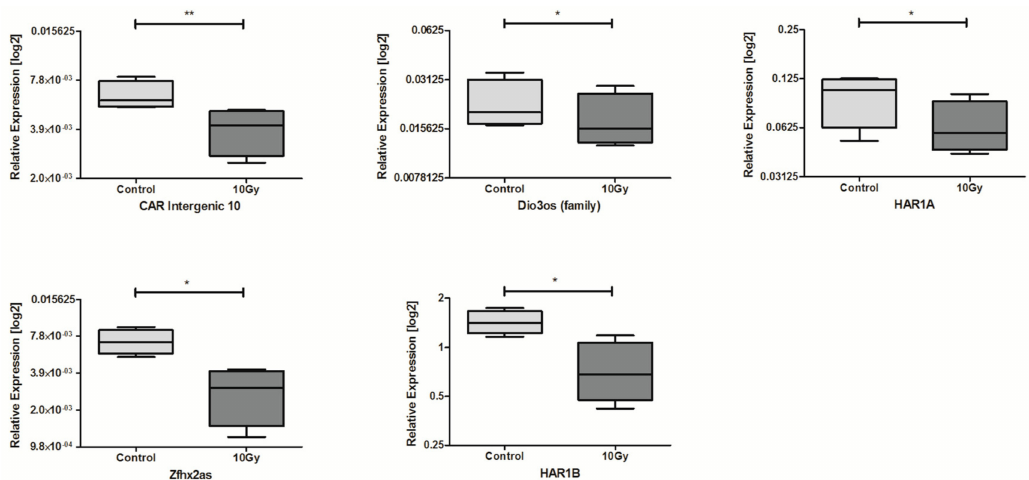
Figure 3. Differences in lncRNAs expression: CAR Intergenic 10, Dio3os (family), HAR1A, Zfhx2as, and HAR1B in HNSCC cell lines after exposure to 10 Gy irradiation and in non-irradiated controls. Paired t -test; the graphs show relative expression, mean value with SEM; * p < 0.05; ** p < 0.01.